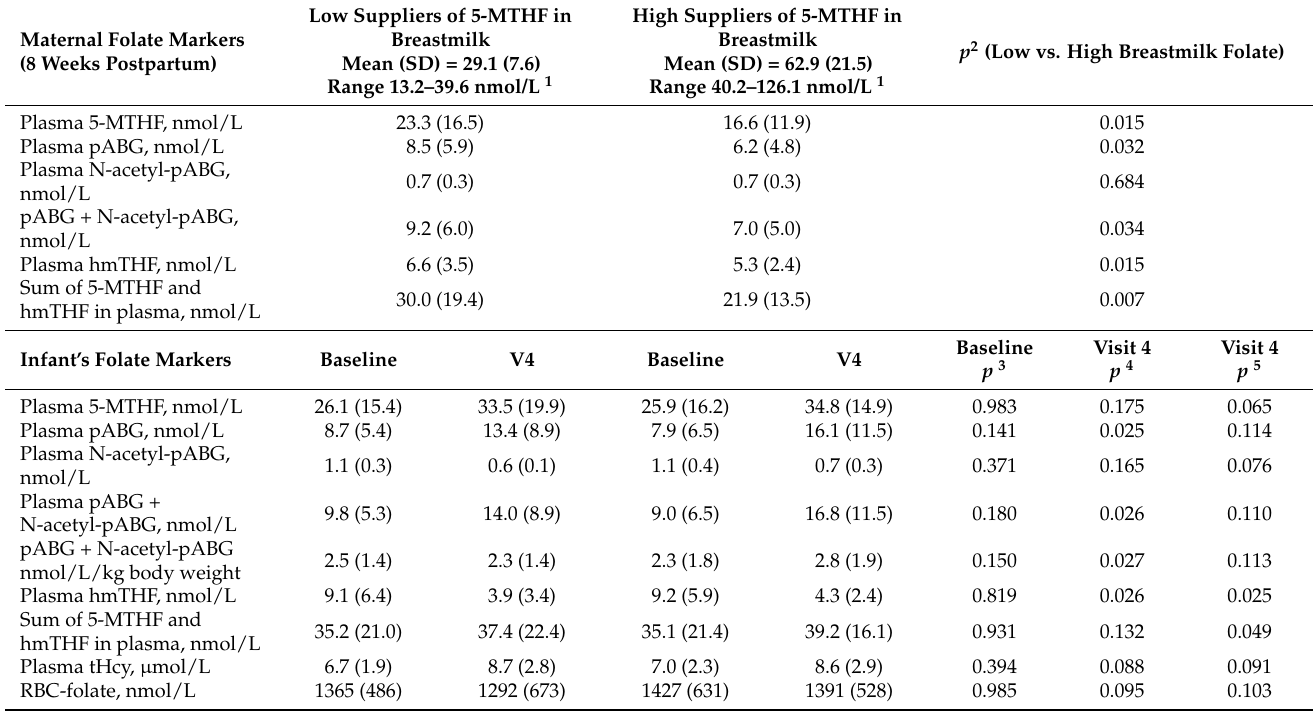
Table 2. Concentrations of folate status markers and catabolites in lactating women and their infants according to breastmilk concentrations of 5-MTHF dichotomized by the median.